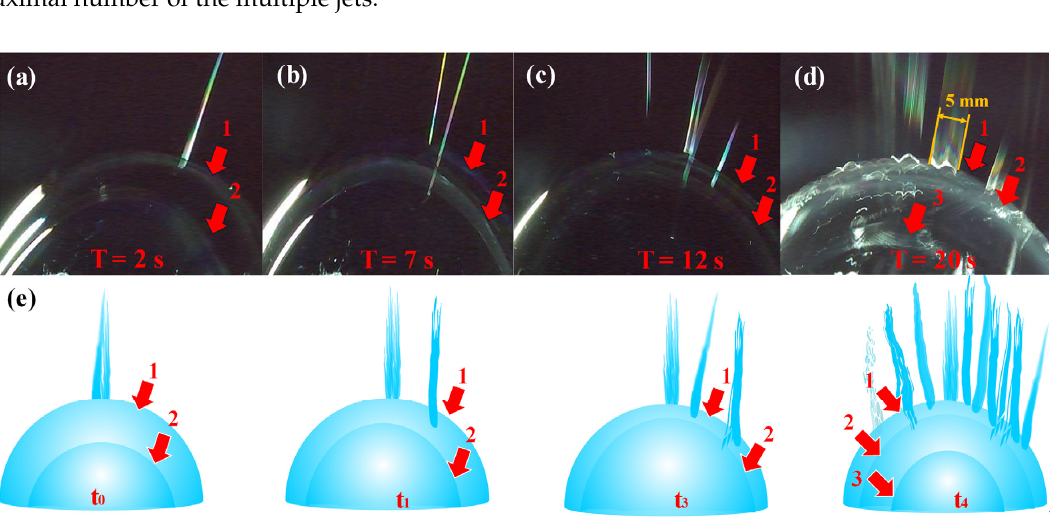
Figure 10. The growth process of bubbles in critical bubble electrospinning: images of continuous bubbles at ( a ) 2s, ( b ) 7s, ( c ) 12s, ( d ) 20s; ( e ) illustrations of the continuously growing bubbles and generated jets.